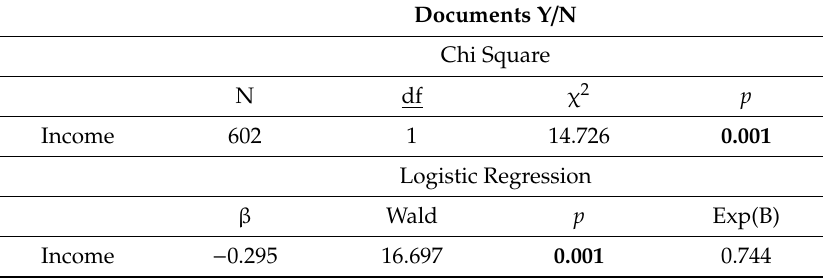
Table 7. Relationship between Income and Needing Assistance with Documents